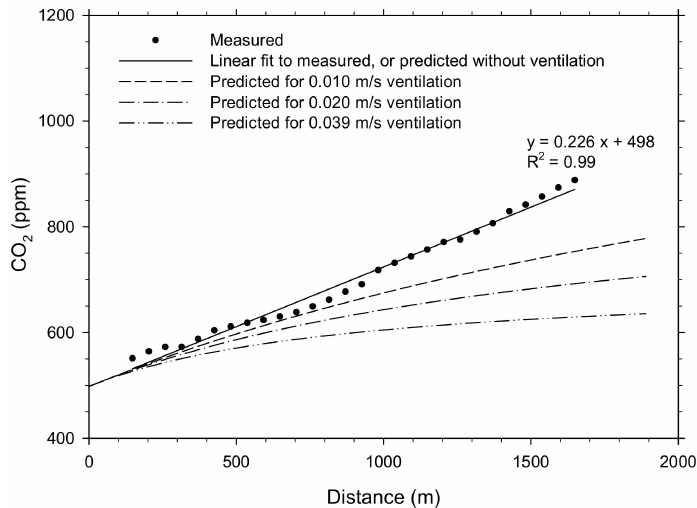
Figure 5. Comparison of measured and predicted CO 2 concentrations inside the Hongjimun Tunnel on 8 February.